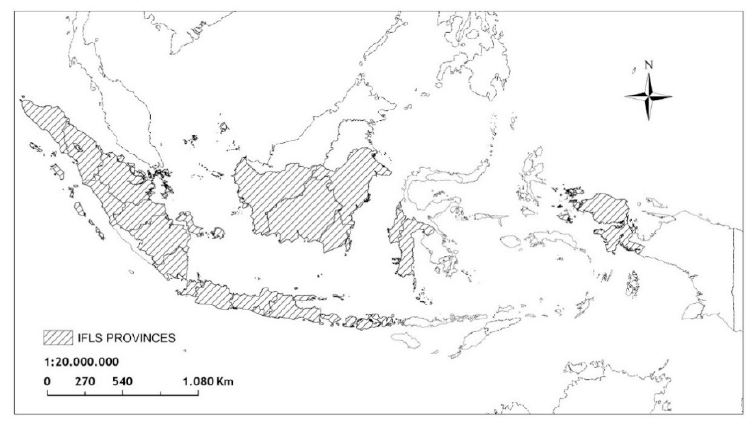
Figure 3. Indonesian Family Life Survey (IFLS) regional coverage.